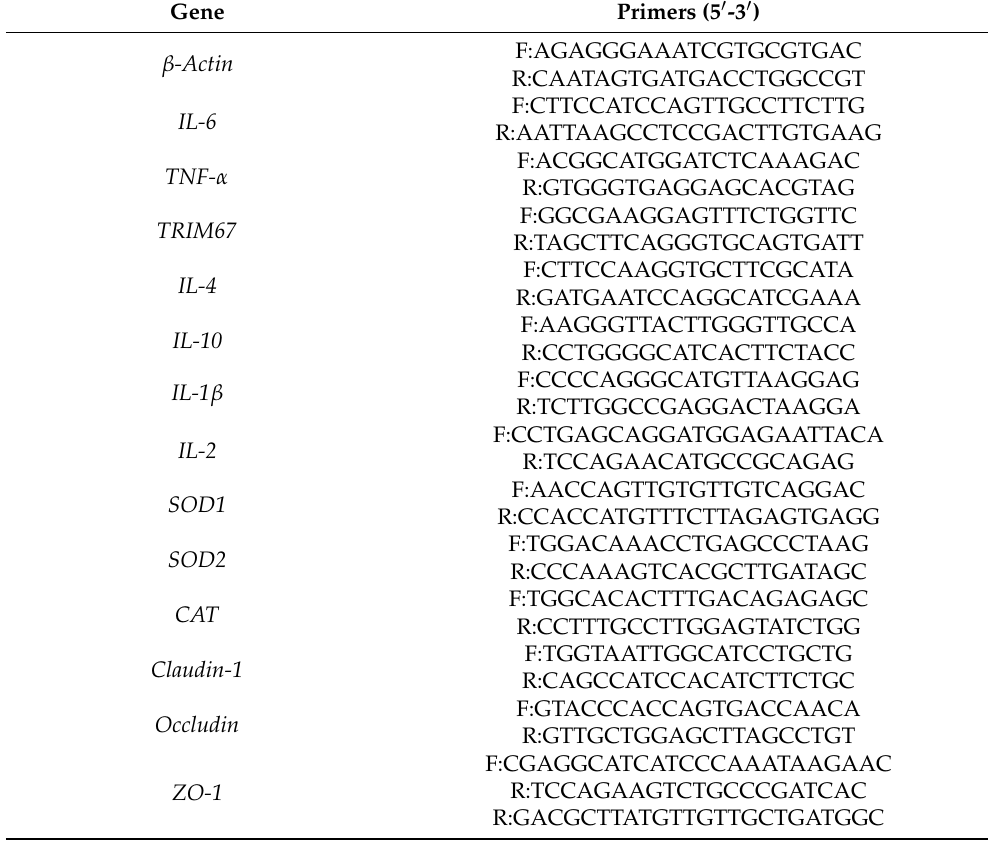
Table 1. qPCR-related primers sequence.